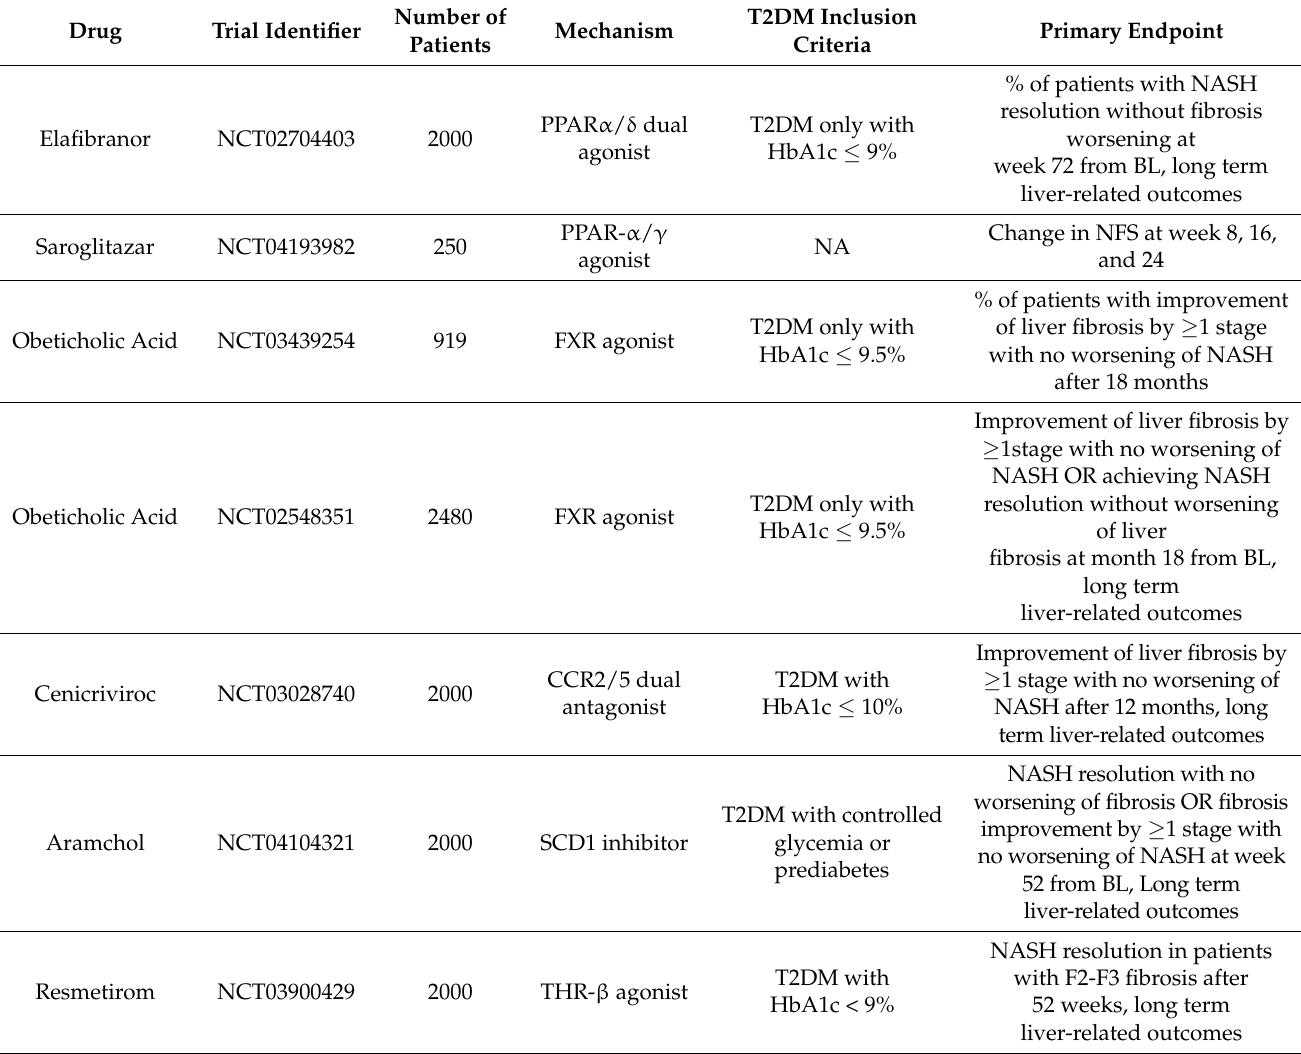
Table 5. Ongoing trials of new medications for the treatment of